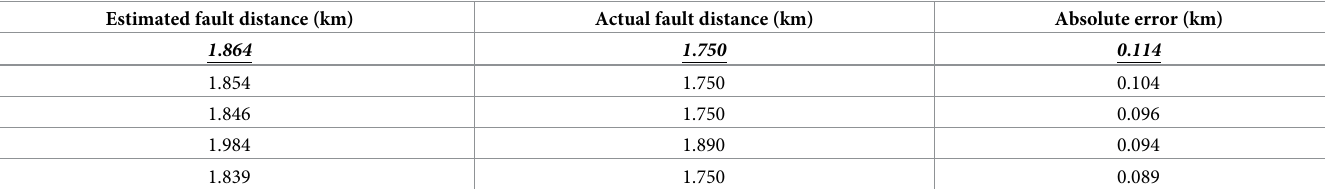
Table 7. Fault distance estimation (BGF).